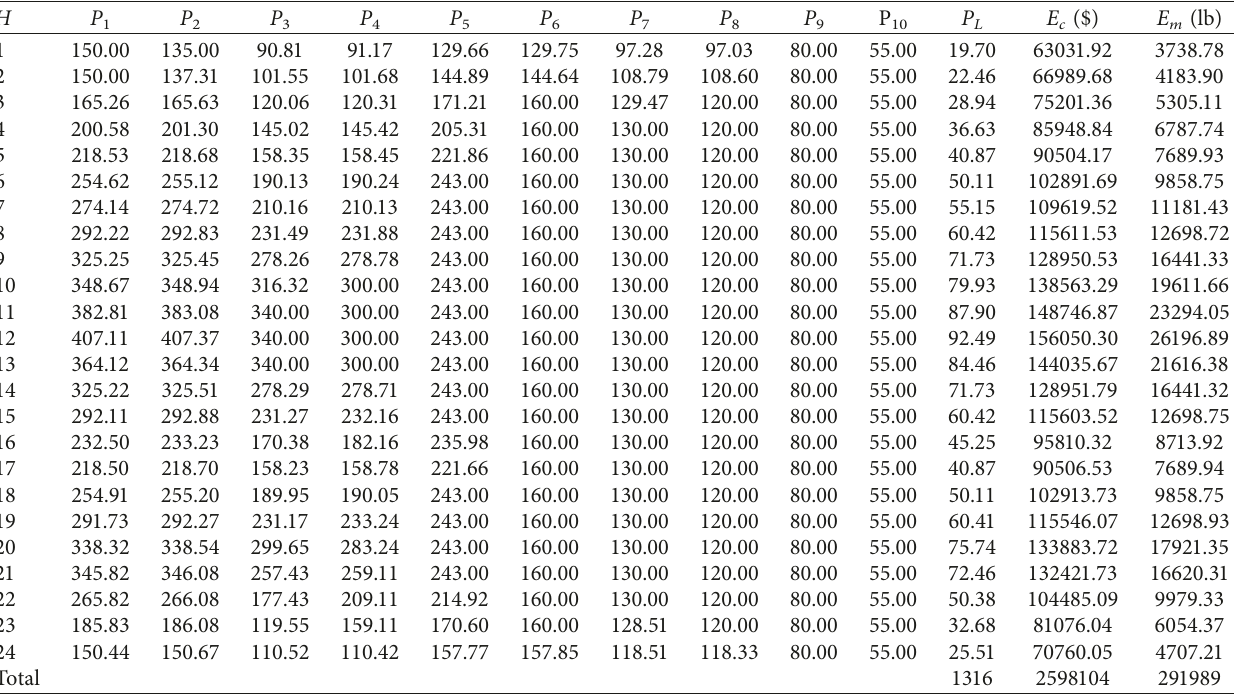
Table 7: Optimal results for Case 2 (optimal